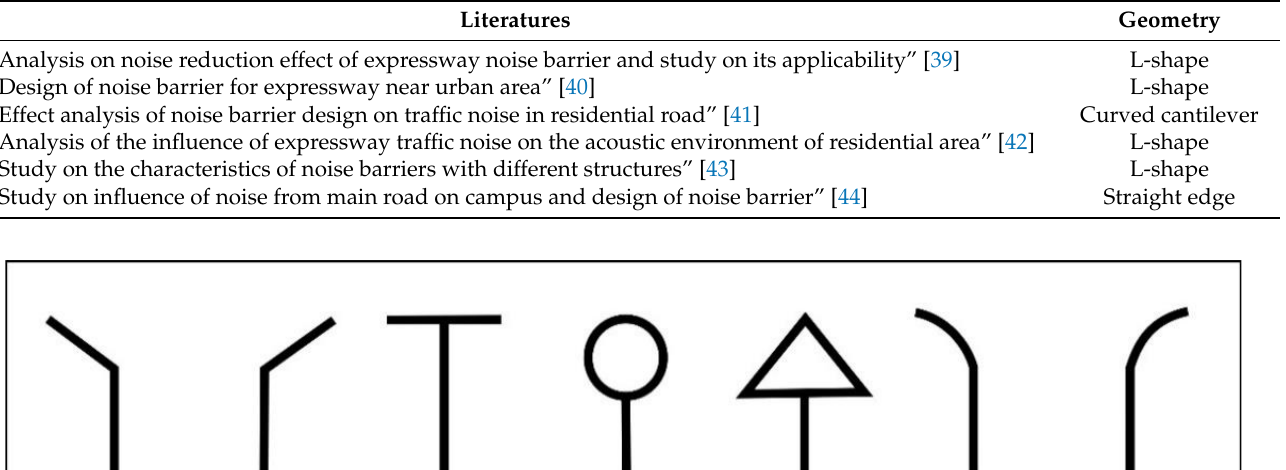
Table 2. Literature review of the geometry of noise barriers.